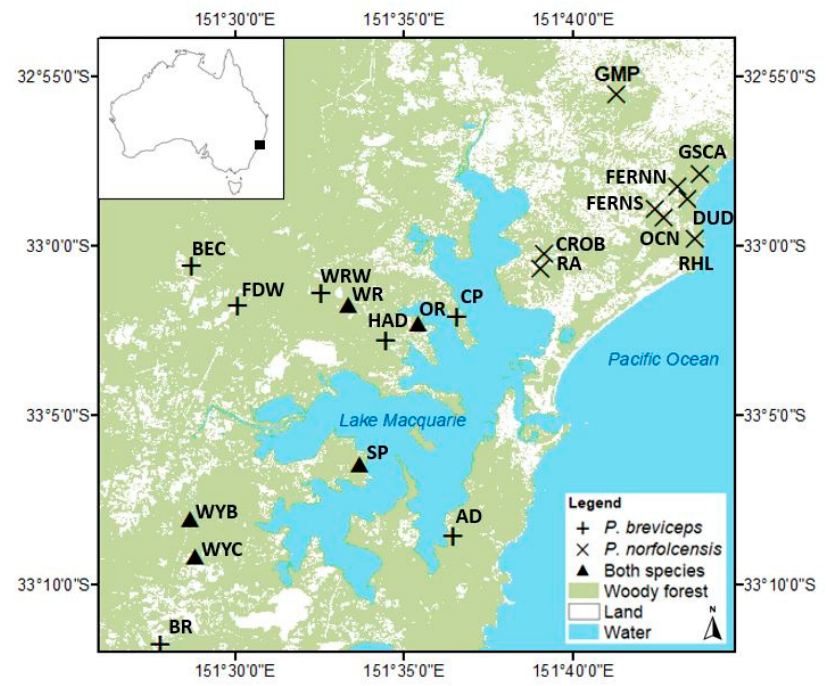
Figure 2. Twenty-one sampling locations of squirrel gliders (P. norfolcensis) and sugar gliders (P. breviceps) in the Lake Macquarie Local Government Area (NSW, Australia). The map shows locations where both species were present during the trapping period (triangles). The location of the potential hybrid is labelled “GMP”. N =